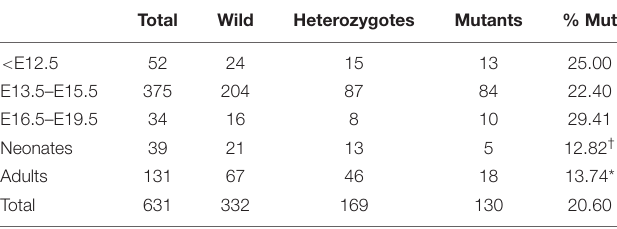
TABLE 2 | Frequency of genotypes by